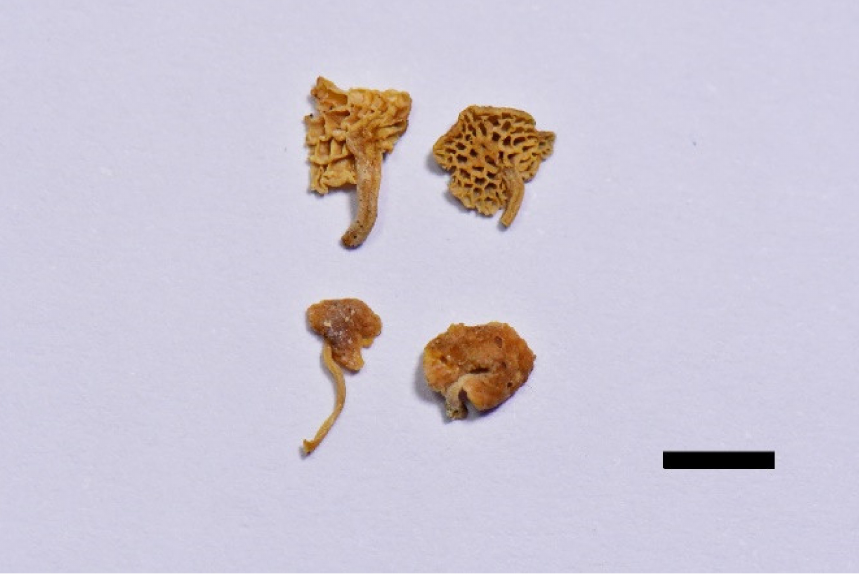
Figure 3. Dried basidiocarps of Favolaschia brevibasidiata (Holotype). Scale bar = 5